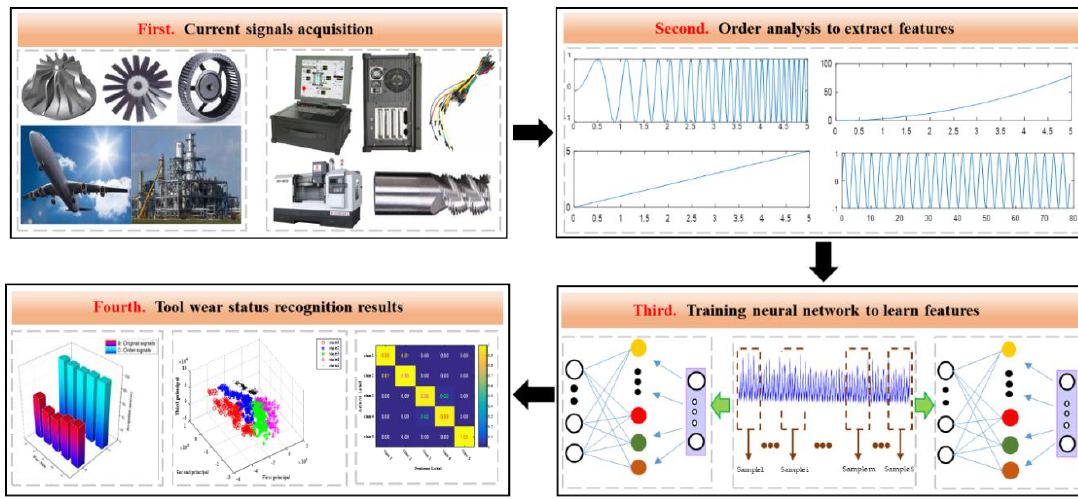
Figure 3. The structure of the proposed method.